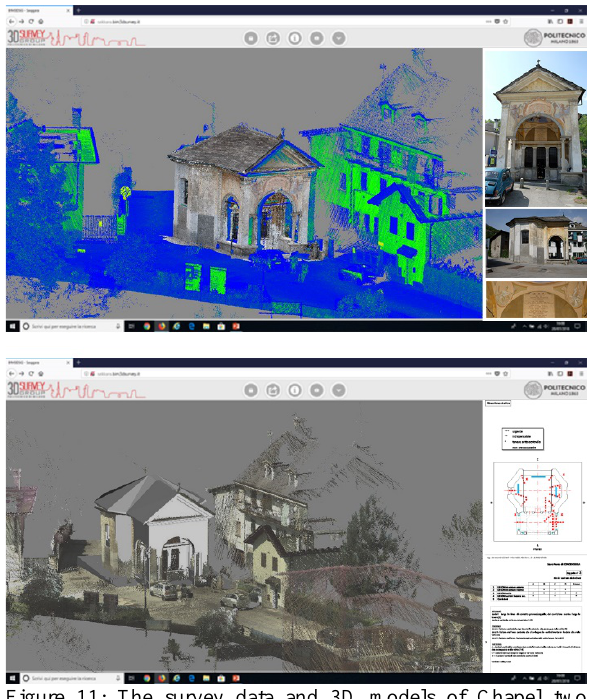
Figure 11: The survey data and 3D models of Chapel two together inside a web-browser and the specific information agreed with the technical office of Ente di Gestione dei Sacri